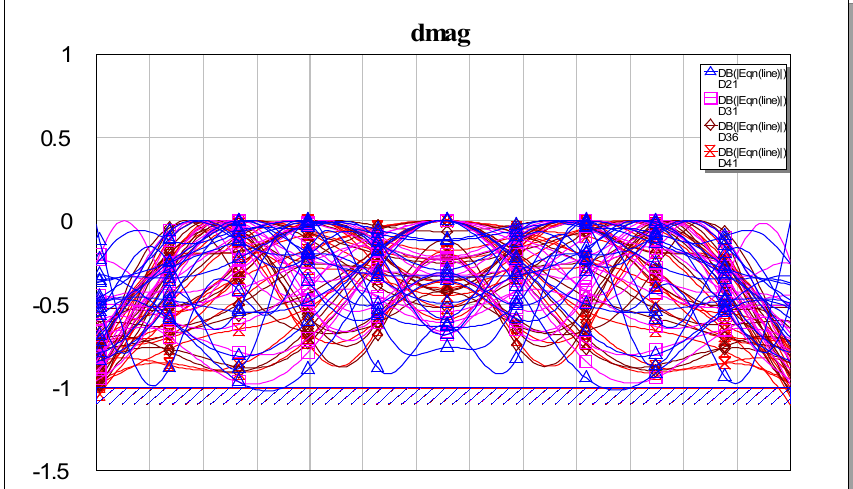
Figure 11. Relative position of plane wave array and field observation line.